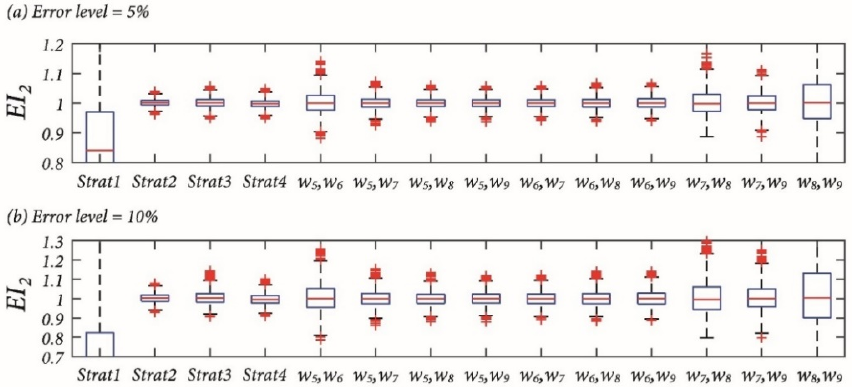
Figure 8. Box plot of the estimations of the bending stiffness EI 2 using different strategies and essential sets with ( a ) error level = 5%; ( b ) error level = 10%. (Strat abbreviated for strategy.)